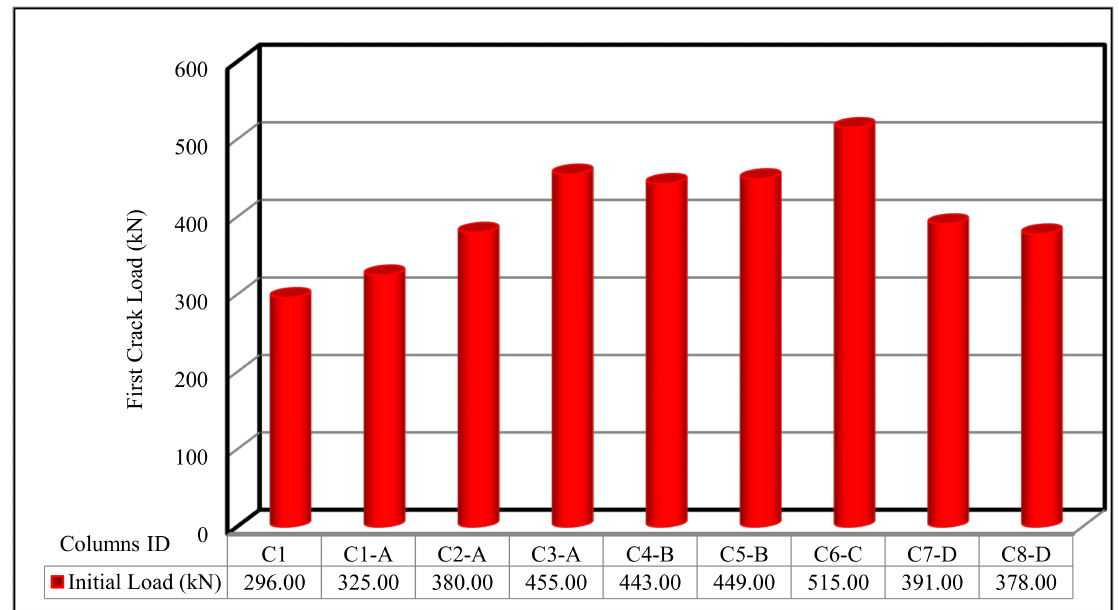
Figure 9. First crack load for the tested